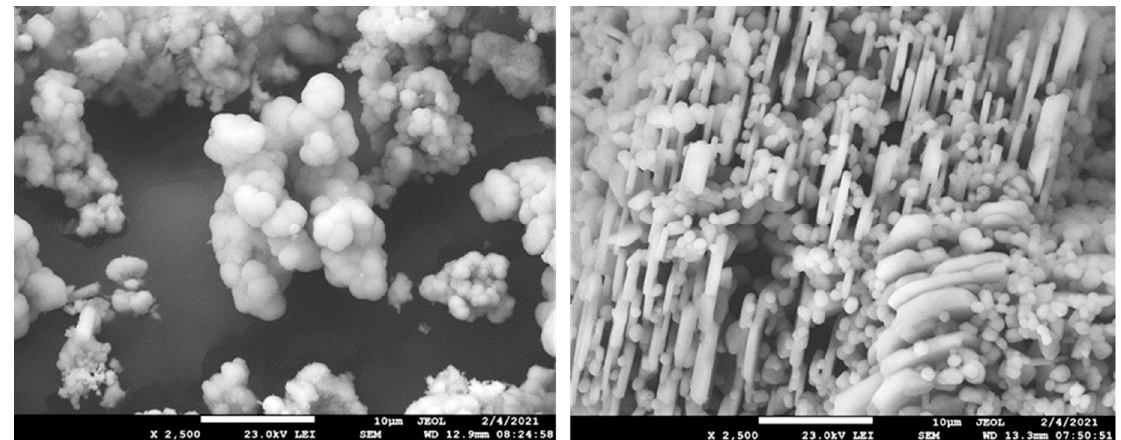
Figure 1. SEM pictures of original powders of zirconia ( left ) and alumina ( right ). Zirconia ceramics has round particles of non-uniform particle size. Based on SEM observation the individual spheres are in range 1–5 µ m. All particles are fused to form stable agglomerates. Contrary to ZrO 2 the alumina is exposing small platelet-like particles morphology surrounded with small round particles. The size of the particles can be approximated to be 10 µ m as the longest diameter and less than 1 µ m as the